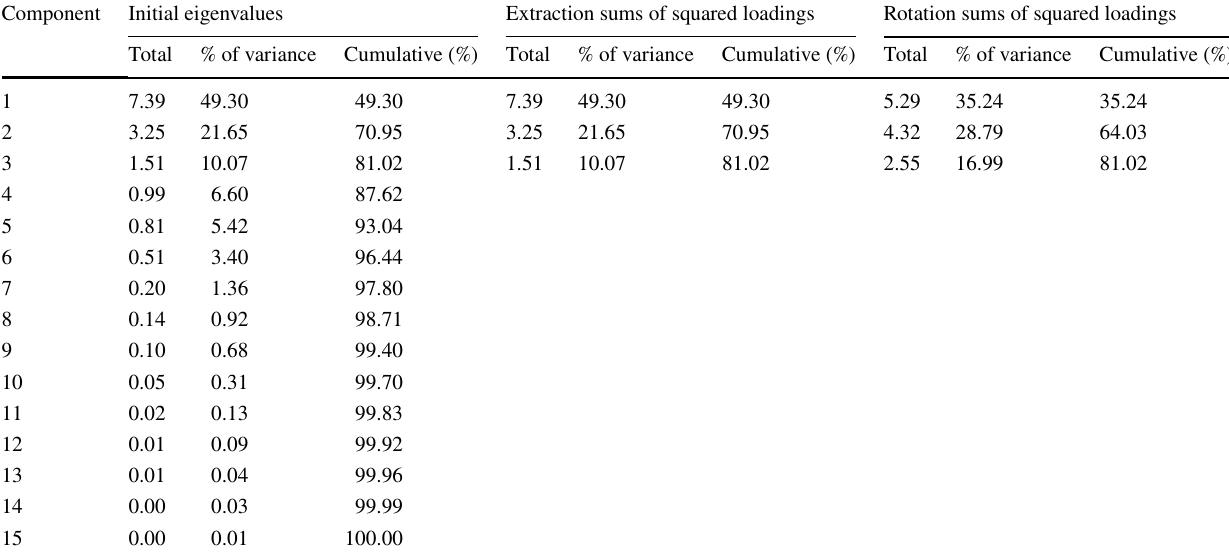
Table 8 Total variance of the watersheds Component Initial eigenvalues Extraction sums of squared loadings Rotation sums of squared loadings